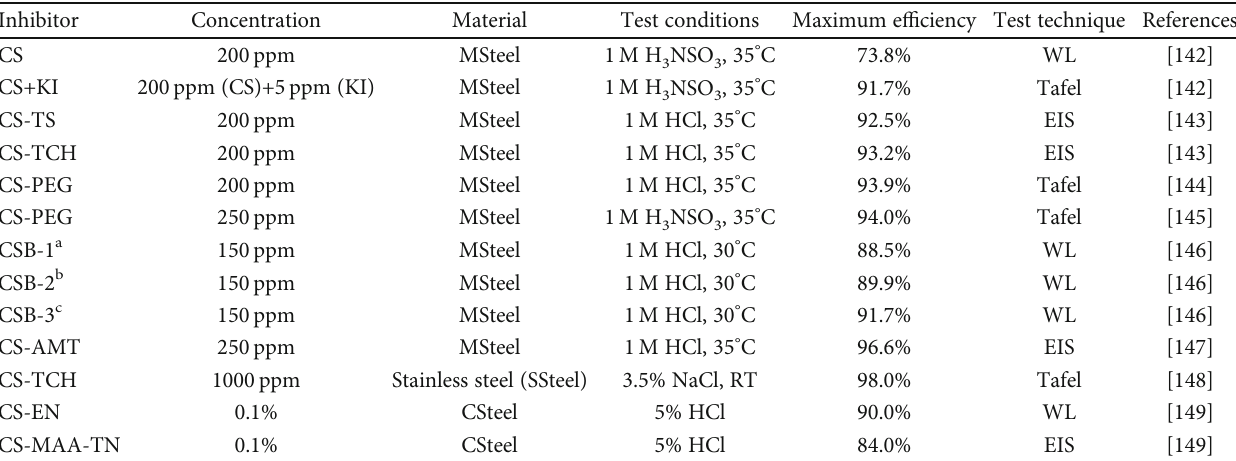
Figure 1: Chemically functionalized chitosan inhibitors. Table 2: Functionalized chitosan as eco-friendly CIs in di ff erent corrosive